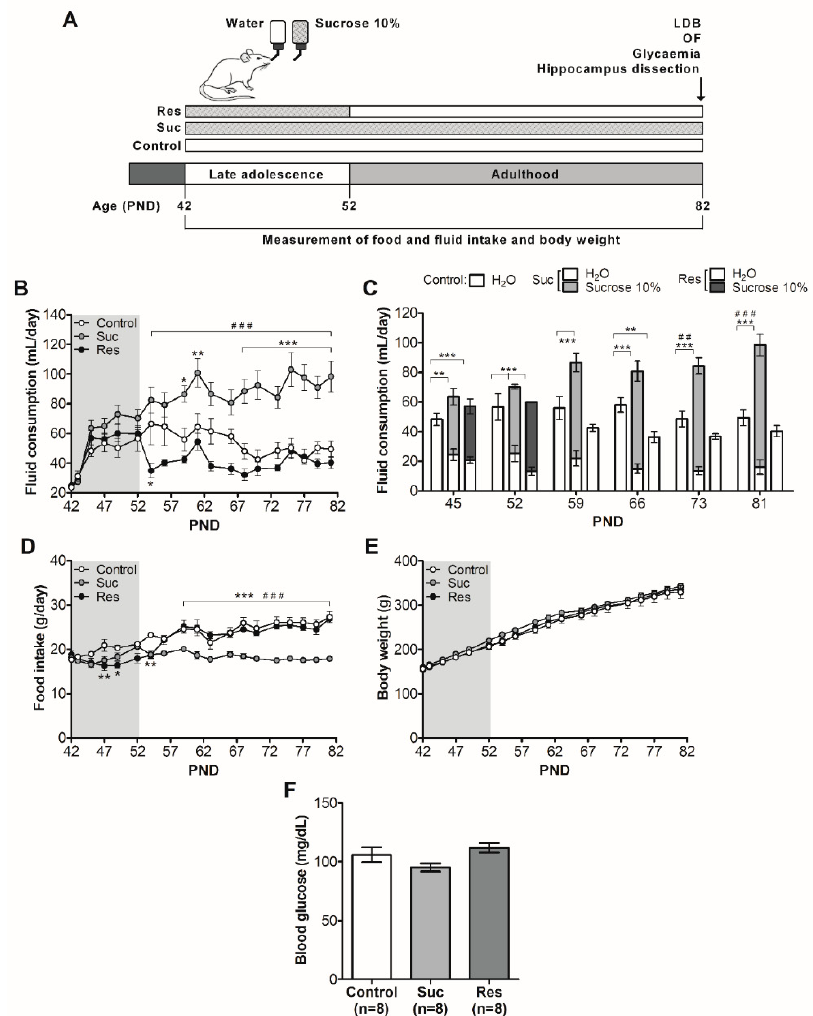
Figure 1. Effect of sucrose consumption on fluid and food intake, body weight and glycaemia. ( A ) Experimental design of the study. ( B ) Total fluid consumption in the experimental groups along the study. * p < 0.05, ** p < 0.01 and *** p < 0.001 Suc vs. control; ### p < 0.001 Suc vs. Res. ( C ) Water and sucrose consumption in the experimental groups. ** p < 0.01 and *** p < 0.001 water intake of the controls vs water intake of the sucrose exposed groups; ## p < 0.01 and ### p < 0.001 water intake of the controls vs sucrose intake of the Suc and Res groups. ( D ) Food intake along the experiment in all groups. * p < 0.05, ** p < 0.01 and *** p < 0.001 Suc vs. control; ### p < 0.001 Suc vs. Res. ( E ) The body weight of rats through the study. ( F ) The blood glucose of the experimental groups at PND 82. Repeated measures Two-Way ANOVA and Bonferroni tests were performed as statistical analysis for ( B – E ) ( n = 8). One-Way ANOVA and Bonferroni tests were performed as statistical analysis for ( F ). The grey area in ( B , D , E ) represents the late adolescence period. LDB: light-dark box test; OF: open field test; PND: postnatal